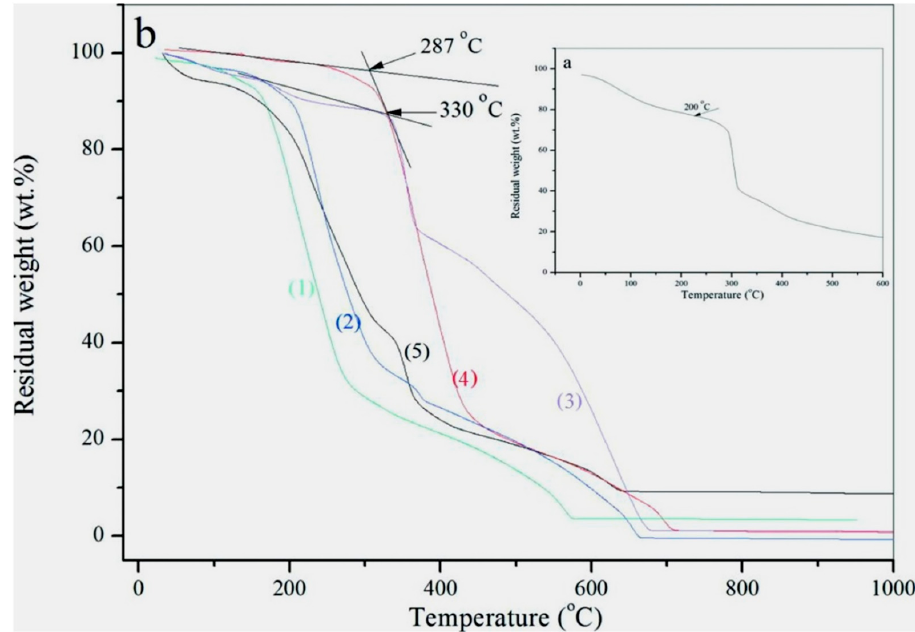
Figure 11. TGA curves of microcapsule samples, ( a ) microcapsules without graphene, ( b ) microcapsule samples prepared under various pH values: (1) M-3, (2) M-4, (3) M-5, (4) M-6 and (5) M-7.